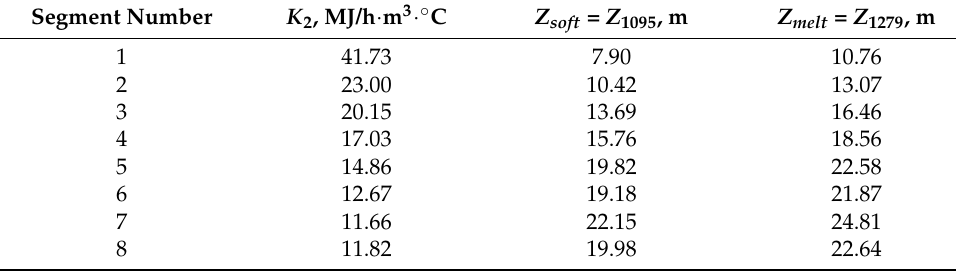
Table 4. Producing zone parameters and cohesive zone situation.